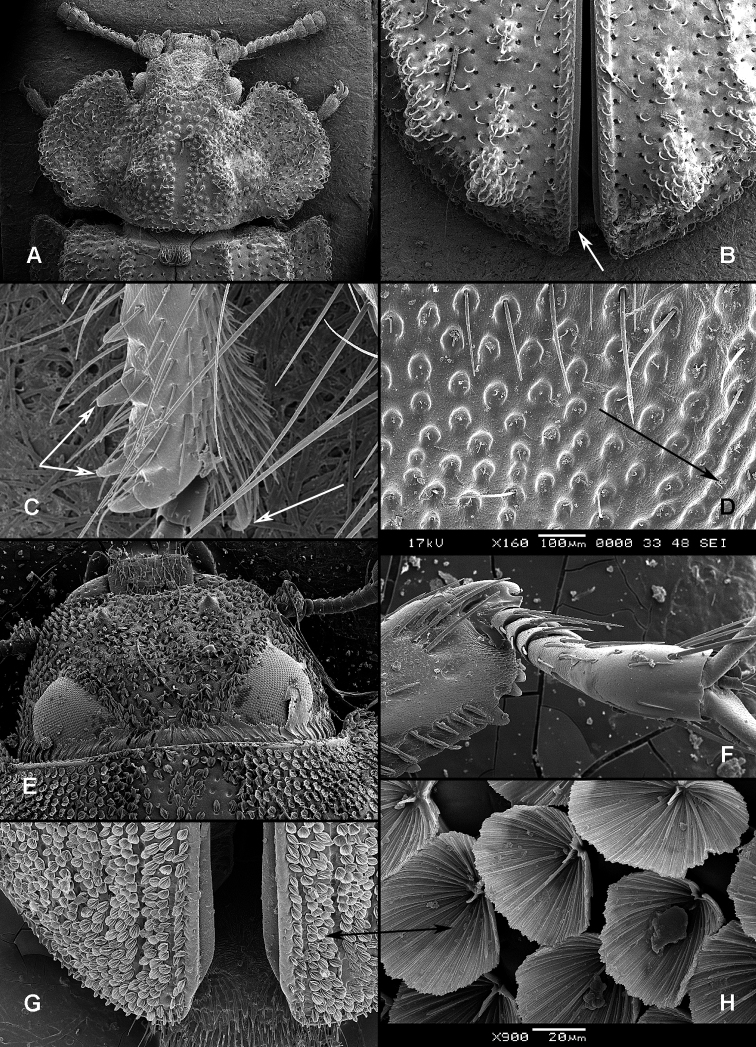
A–B
Calitys scabra (A head and pronotum B elytral apex with interlocking mechanism) C–D
Acalanthis quadrisignata (C apex of protibia with hooked spur and lateral spines D sculpture of frons with punctures conjoined into wrinkles) E–H
Gymnocheilis sp., Cameroon (E head F protibia G elytral apex H detail of scales).